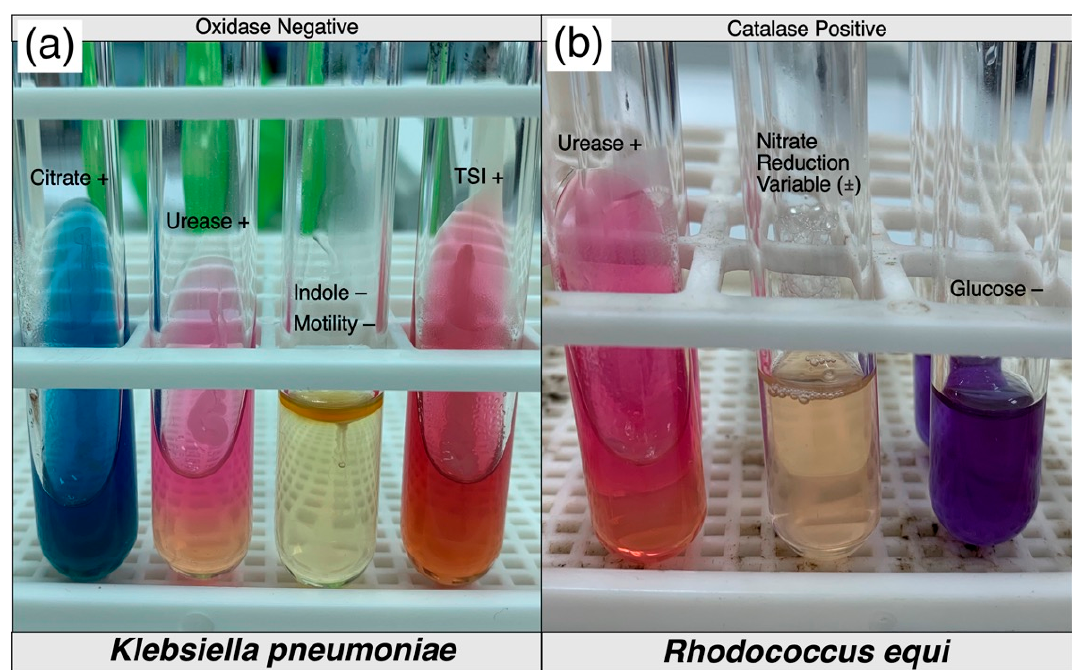
Figure 5. Conventional biochemical testing results of ( a ) K. pneumoniae and ( b ) R. equi , isolated from